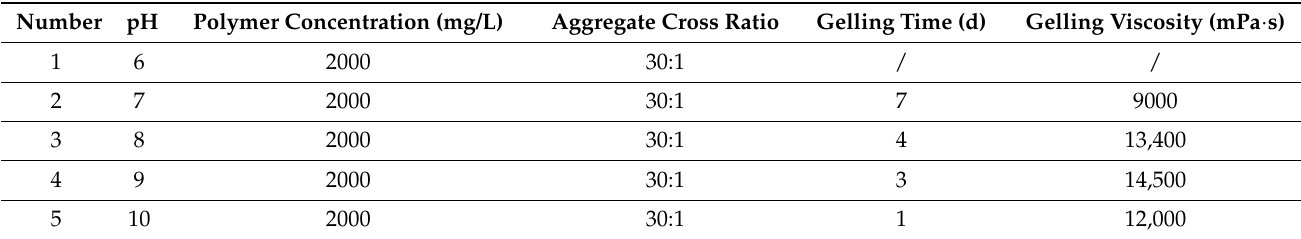
Table 3. The effect of pH on gel formation.